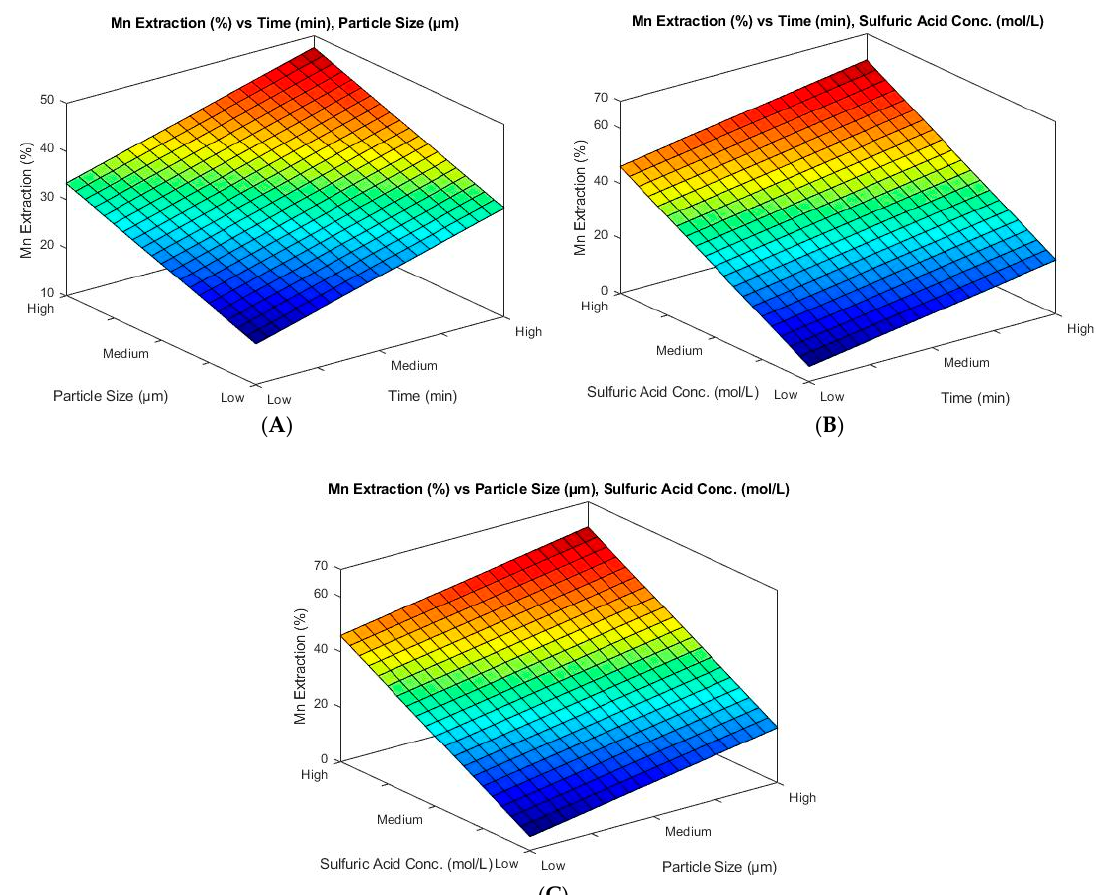
Figure 11. Response surface of the independent variables of time and particle size ( A ); time and H 2 SO 4 concentration ( B ); and particle size and H 2 SO 4 concentration ( C ) on the dependent variable of Mn extraction.